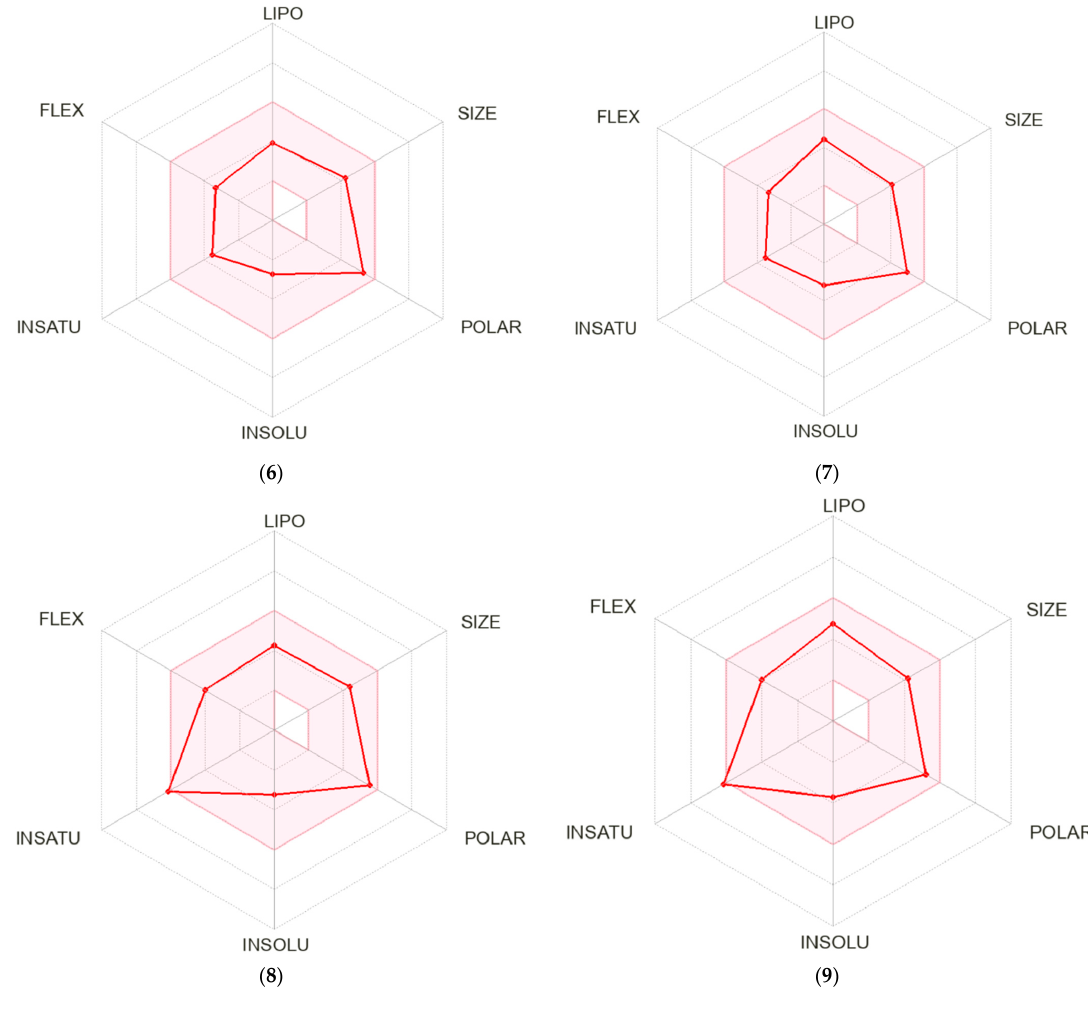
Figure 5. Bioavailability radar for 4 – 9 .